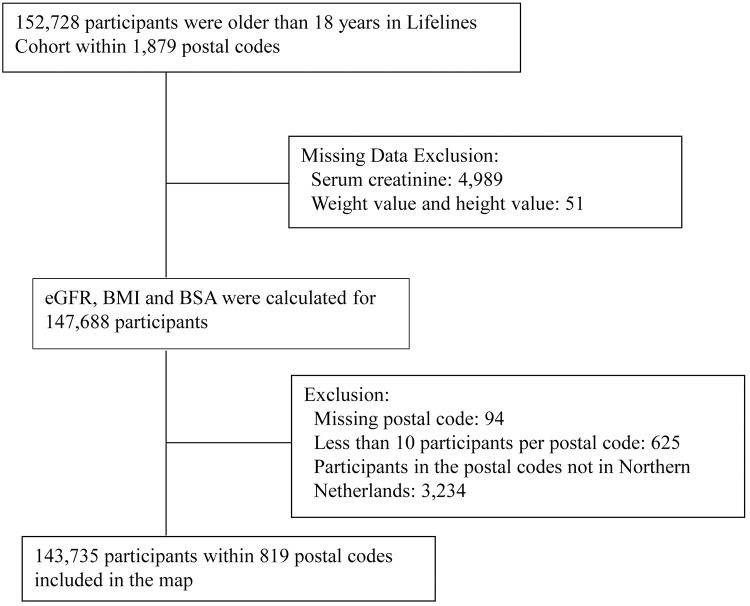
Flow chart of participants selection.